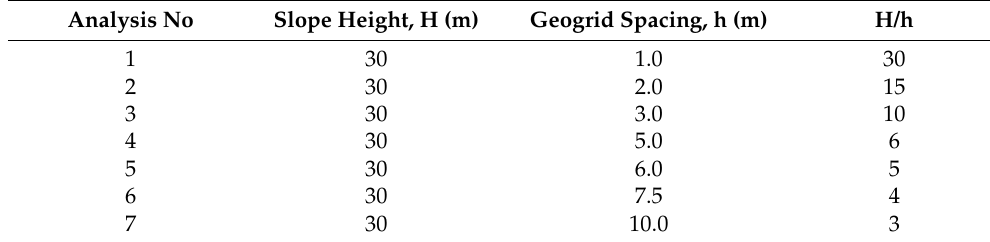
Table 6. Reinforced analysis sets.